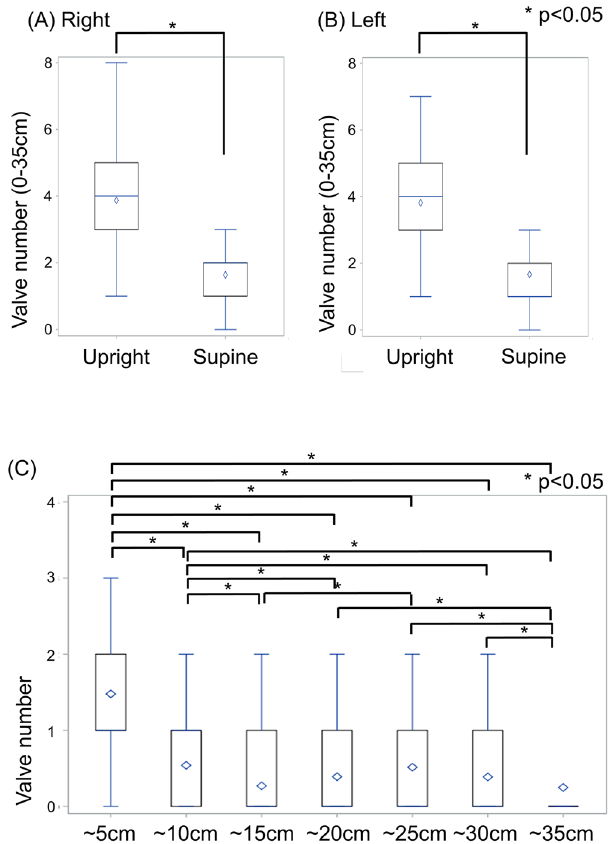
Figure 3. Valve numbers and distribution in upright and supine CT. Valve numbers in the upright and supine CT in ( A ) right side and ( B ) left side. On both sides, the valve numbers were significantly higher in the upright CT. ( C ) The distribution of valves in upright CT was highest in the lesion from the SF junction to 5 cm, followed by 5 to 10